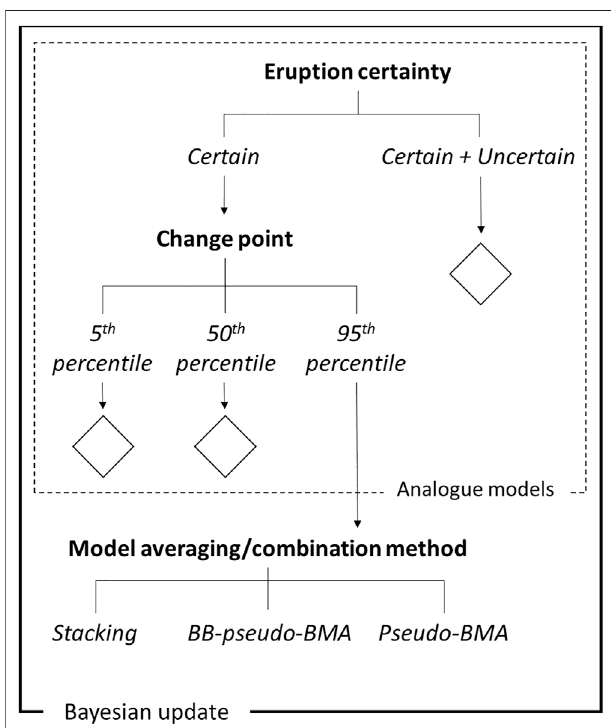
FIGURE 3 | Variations used in the sensitivity analysis for the 74 volcanoes that undergo Bayesian updating. Diamonds denote branches that clone adjacent branches, but are not displayed on the fi gure for clarity